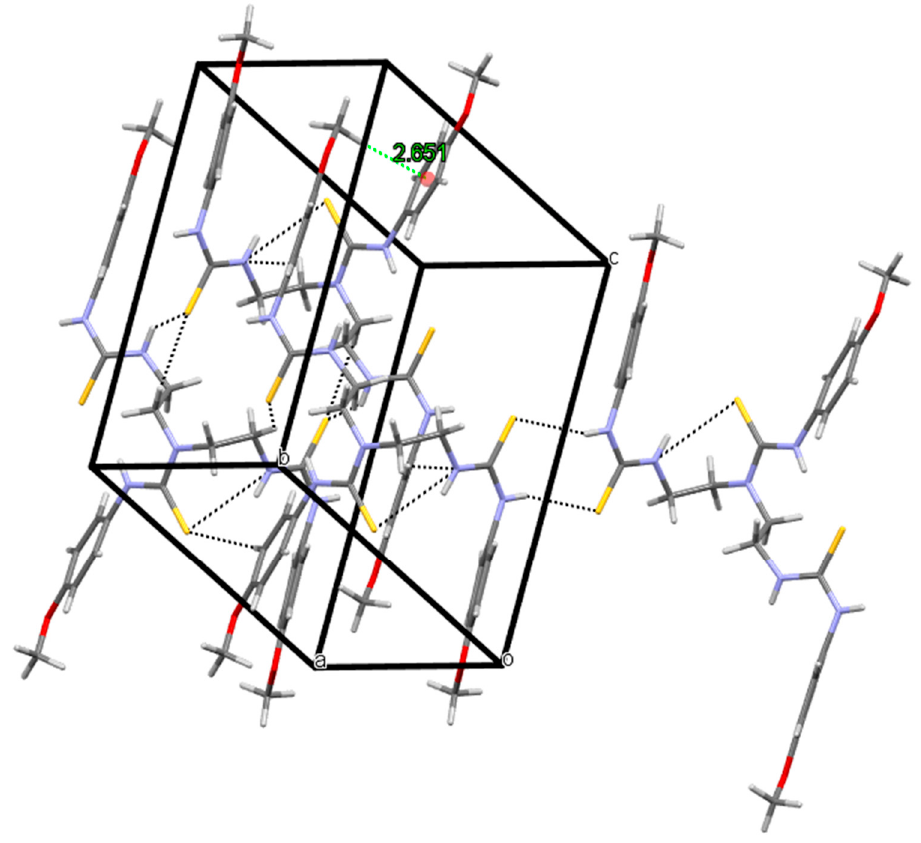
Figure 3. The packing and selected interactions in the crystal lattice of 3-(4-methoxyphenyl)-1,1-bis{2-[3-(4-methoxyphenyl)thioureido]ethyl}thiourea ( 1 ). 3-(4-methoxyphenyl)-1,1-bis(2-{[1-(4-methoxyphenyl)-1H-tetrazol-5-yl]amino}ethyl)thiourea ( 7 ) also crystallizes in a triclinic system, space group P-1, with one molecule in an asymmetric part of